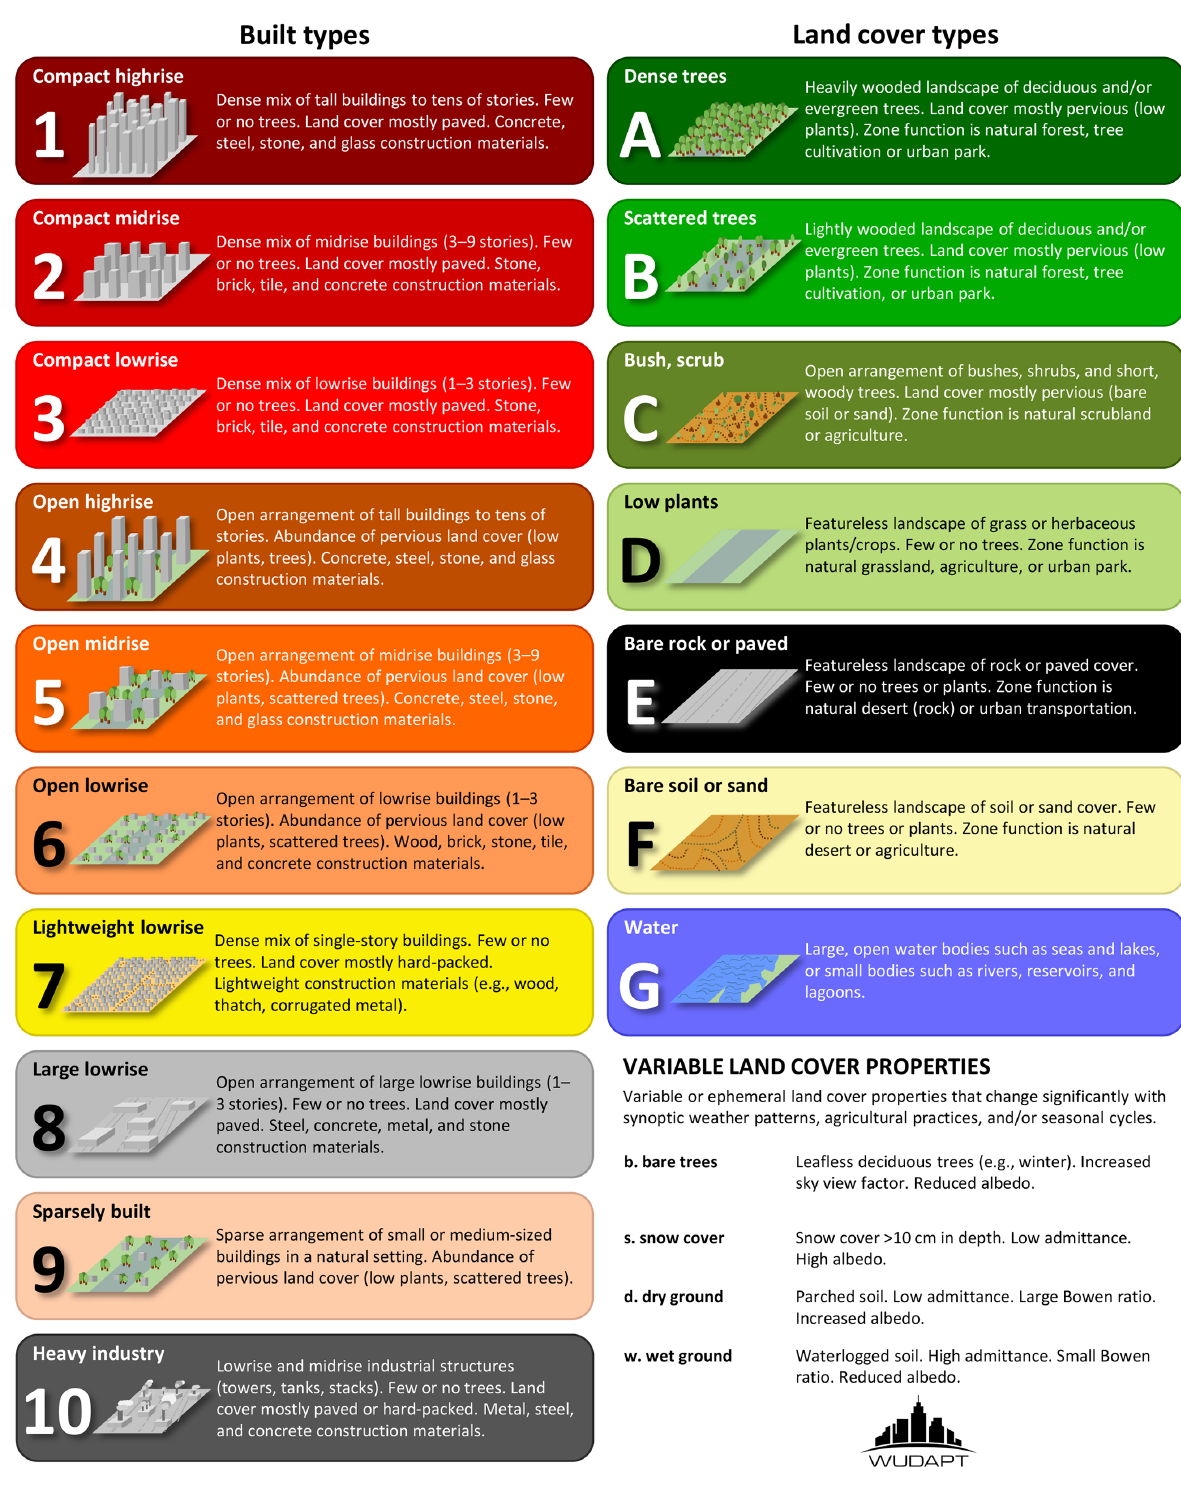
Figure 1. Definitions of built (1–10) and land cover types (A–G) for the local climate zone scheme (Stewart and Oke, 2012; Demuzere et al., 2020a).